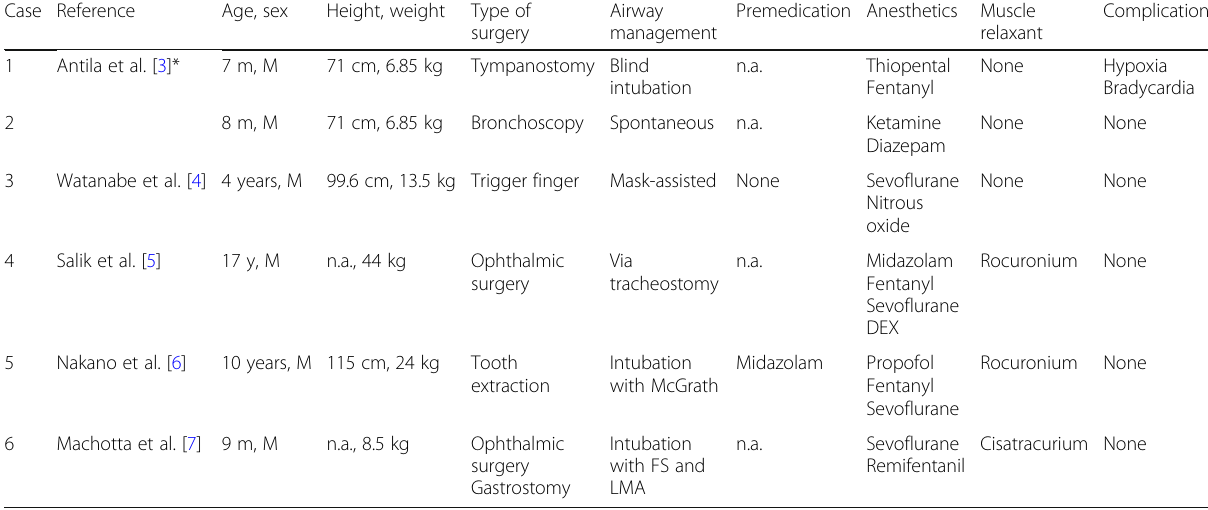
Table 1 Previous case reports of anesthetic management for